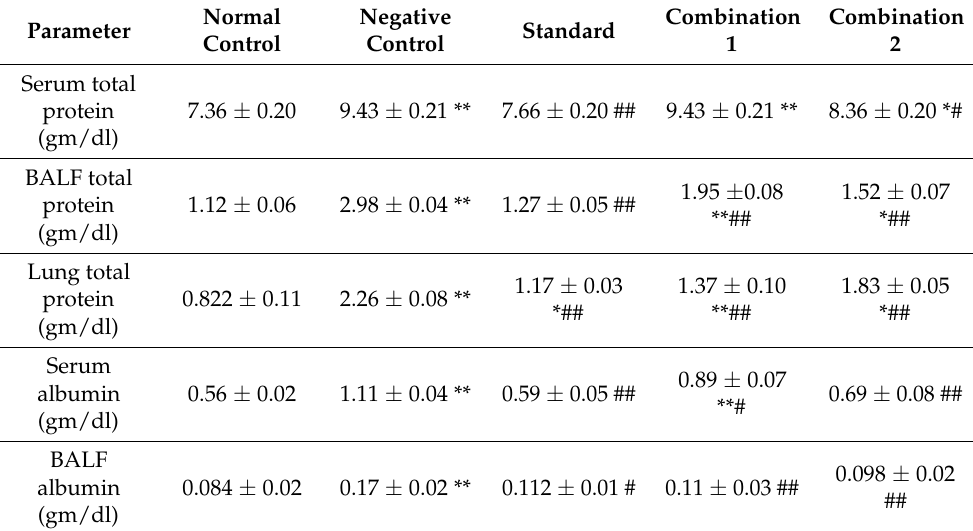
Table 3. Effect of treatment combination on OVA-induced alteration in the levels of total protein and albumin in serum, BALF and lung tissues of